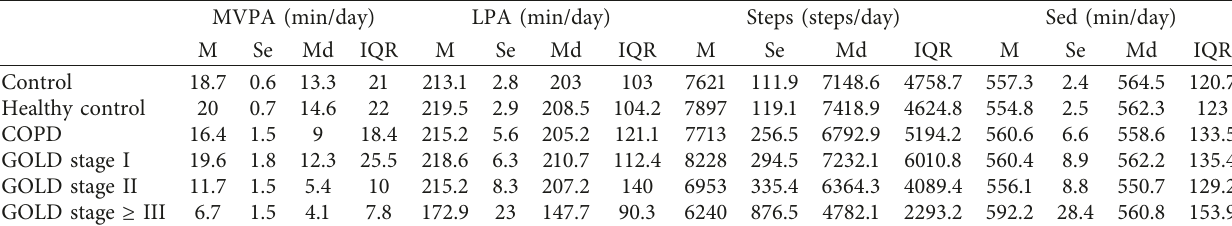
Table 2: Weighted characteristics of physical activity and